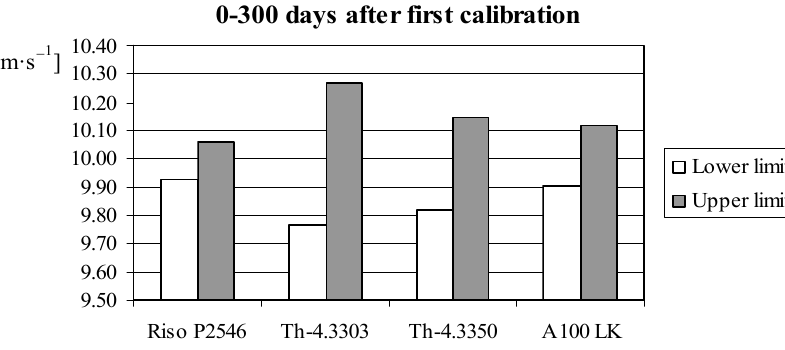
Figure 8. 68.2% confidence limits for the variation in the interval between 0 and 300 days after the first calibration, of the measured wind speed at 10 m·s − 1 with regard to the anemometers studied. Measured wind speed variation at 10 m/s 0-300 days after first